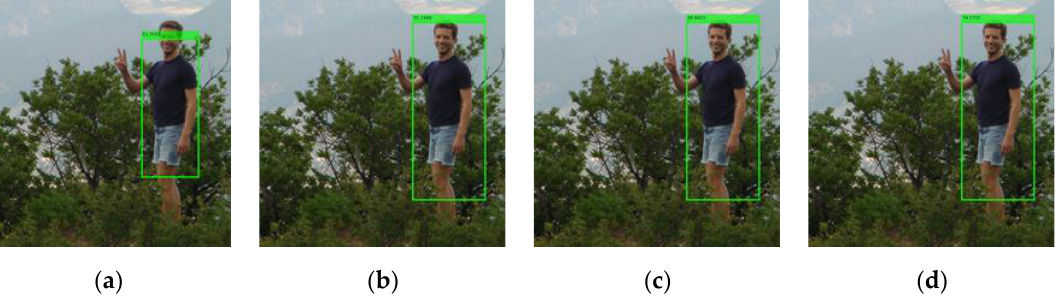
Figure 15. The detection results of the integrated detector with 𝑓 𝑠𝑠 = 1,5, 8, 10 for ( a – d ) respec- tively.